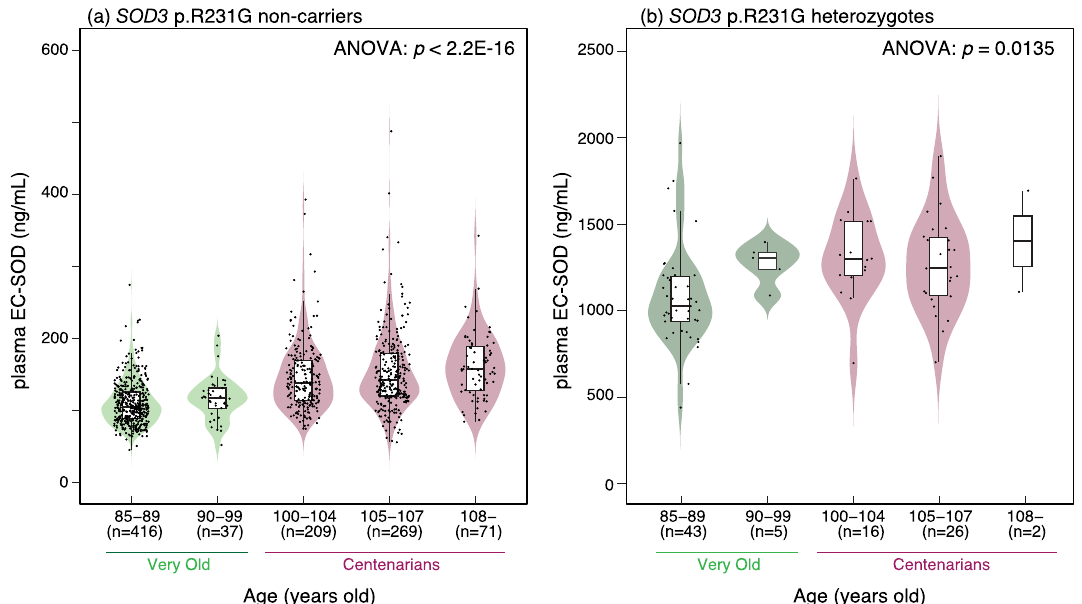
Figure 3. Distribution of plasma EC-SOD concentration by age. ( a ) Distribution of plasma EC-SOD concentration in SOD3 p.R231G non-carriers by age. The distribution of plasma EC-SOD concentration classified by age showed a significant difference in SOD3 p.R231G non-carriers (ANOVA: p < 2.2 × 10 −16 ). ( b ) Distribution of plasma EC-SOD concentration in SOD3 p.R231G heterozygotes by age. The distribution of plasma EC-SOD concentration classified by age showed a significant difference in SOD3 p.R231G heterozygotes (ANOVA: p = 0.0135). These results suggest that the concentration of plasma EC-SOD increases depending on the age in the Very Old and Centenarian carriers showed a difference between the Very Old and Centenarian groups. To evaluate the difference in plasma EC-SOD concentration distribution in detail, we compared the distribution of plasma EC-SOD concentration by age in SOD3 p.R231G variant non-carriers (Fig. 3a) and heterozygotes (Fig. 3b). The results showed that the distribution of the concentration of plasma EC-SOD by age was significantly different in both the SOD3 p.R231G variant non-carriers (ANOVA: p < 2.2 × 10 −16 ) and SOD3 p.R231G heterozygotes (ANOVA: p = 0.0135). In the SOD3 p.R231G variant non-carriers, the median of plasma EC-SOD concentration was gradually dependent on age, and the distribution range in the centenarians increased compared with that in the Very Old group, indicating that the plasma EC-SOD concentration in individuals with identical SOD3 p.R231G genotypes would increase depending on the ages in the Very Old and Centenarian periods. Association between plasma EC-SOD concentration and medical history in SOD3 p.R231G variant non-carriers in the Very Old and Centenarians. To evaluate the association between plasma EC-SOD concentration and comorbidity in SOD3 p.R231G variant non-carriers, we compared medical history including CKD, diabetes, stroke, CHD, and pneumonia among the top and bottom half groups of the EC-SOD concentration in SOD3 p.R231G variant non-carriers of the entire cohort, Very Old, and Centenarians (Fig. 4). The results showed that a higher plasma EC-SOD concentration in the SOD3 p.R231G variant non-carriers was associated with a high odds ratio for CKD in both the Very Old and Centenarians, while a higher plasma EC- SOD concentration was associated with a low odds ratio for DM only in the Very Old group. This indicates that the increment of plasma EC-SOD concentration for SOD3 p.R231G variant non-carriers is associated with both DM and CKD in the Very Old group; however, this is only associated with CKD in the Centenarians. Association between plasma EC-SOD concentration and plasma biomarkers in SOD3 p.R231G variant non-carriers. The concentration of biomarkers in plasma is expected to provide important infor- mation on the pathophysiology of age-related diseases in the Oldest Old. To detect the plasma biomarkers associated with plasma EC-SOD concentration, we compared plasma EC-SOD concentration with plasma bio- markers for DM and cardiovascular disease (adiponectin and hemoglobin A1C [HbA1c], N-terminal pro-brain natriuretic peptide [NTproBNP]), renal function (cystatin C [CstC] and estimated glomerular filtration rate with creatinine correction [eGFRcreat]), cholesterol metabolism (total cholesterol [TCHO], high density lipo- protein cholesterol [HDLC], low-density lipoprotein cholesterol [LDLC]), and inflammation (tumor necrosis factor-alpha [TNF-α], interleukin-6 [IL-6], and C-reactive protein [CRP]) (Fig. 5a–c). The results revealed that the plasma EC-SOD concentration was correlated with the concentration of adiponectin in plasma (Fig. 5a–c, r = 0.41, p < 2.2 × 10 −16 ; r = 0.43, p × 10 −16 ; r = 0.31, p = 5.1 × 10 −14 in the entire, Very Old, and Centenarians, respec- tively). Adiponectin is known to be one of the adipokines secreted from the adipose tissue and it possesses an antidiabetic effect; therefore, a higher adiponectin concentration associated with plasma EC-SOD concentration